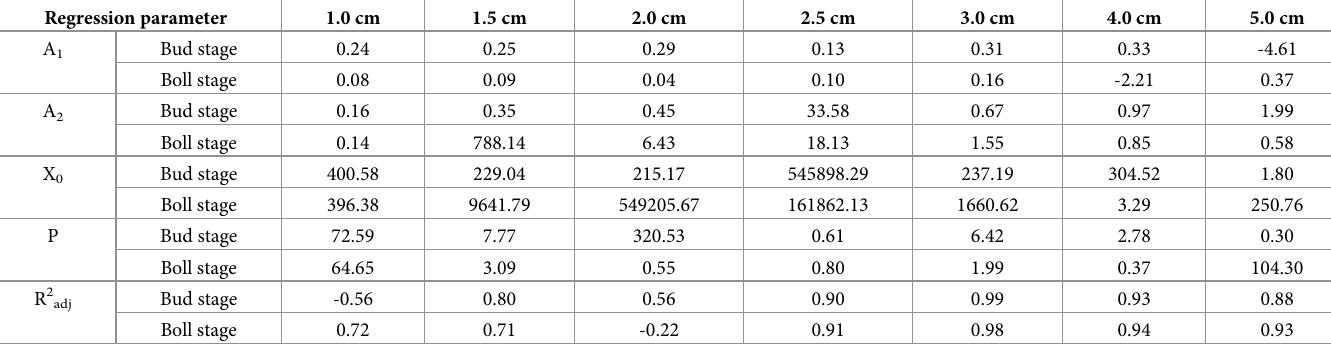
Table 6. Regression parameters of the logistic equations between the branch injury rate and hail fall density. Regression